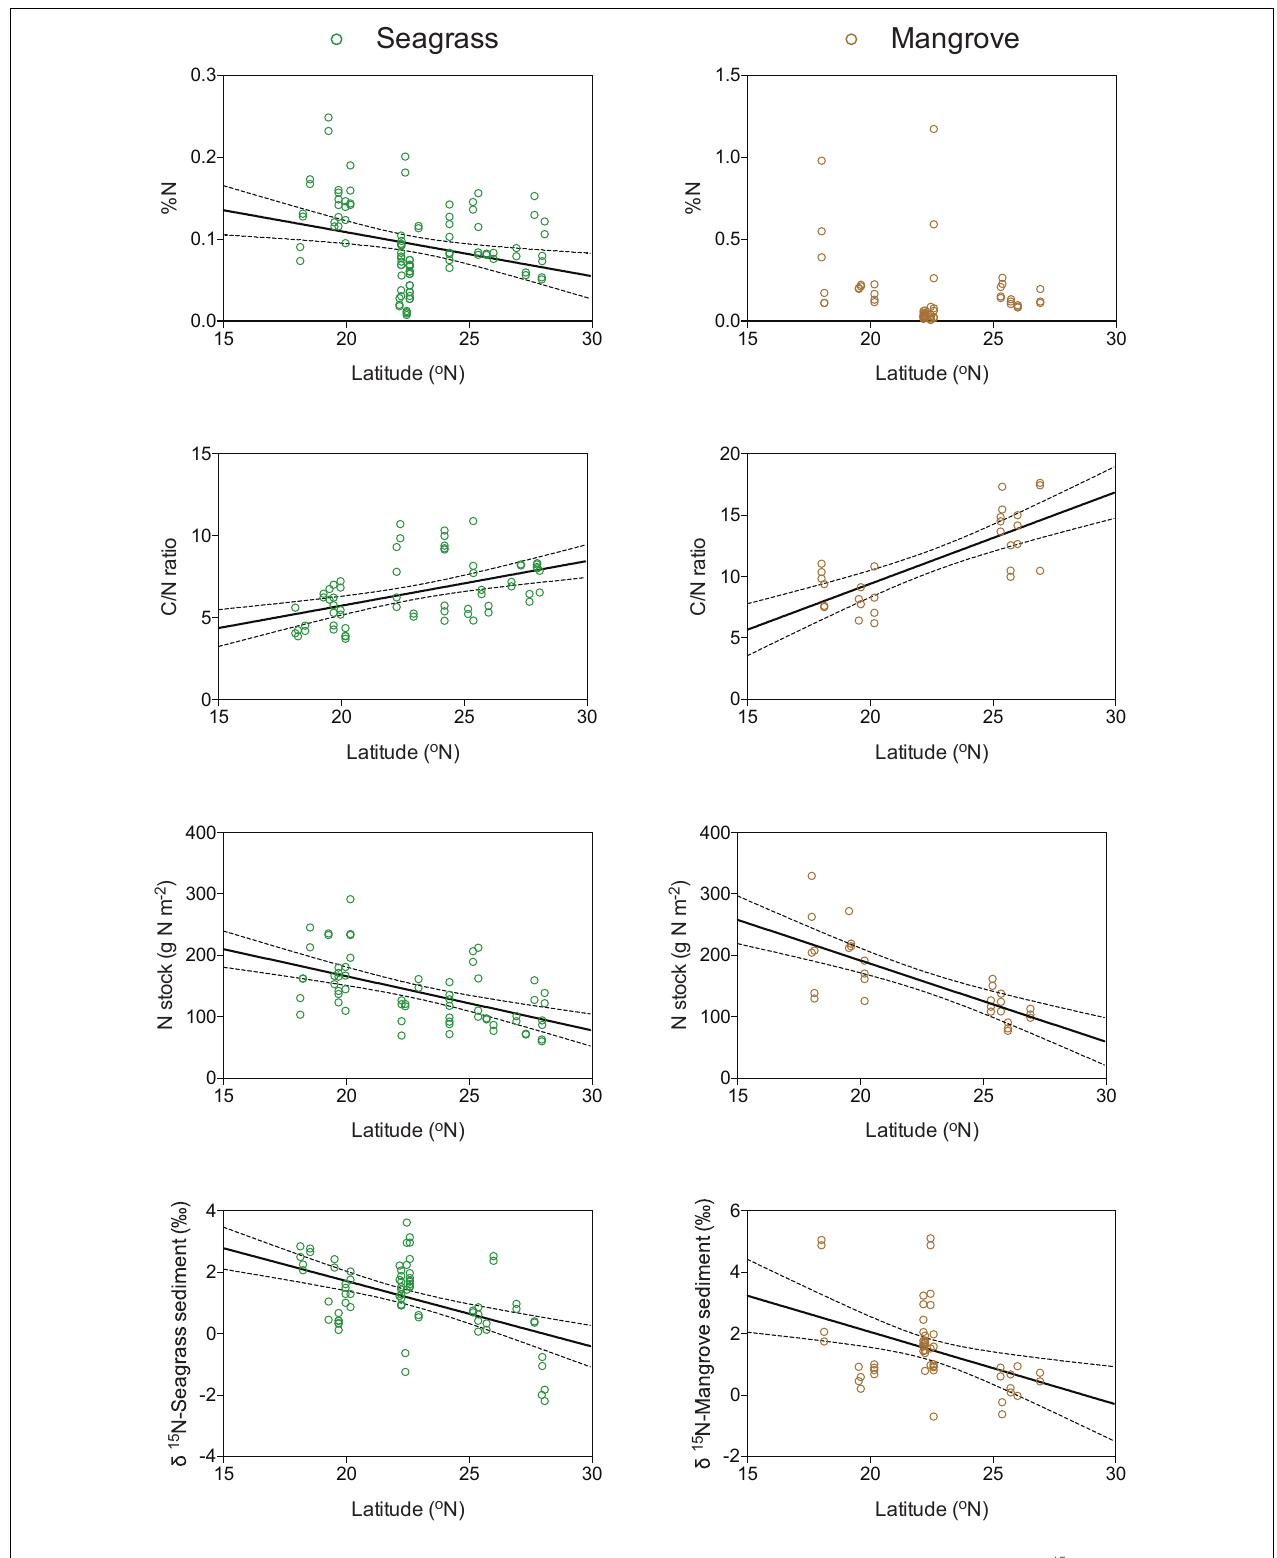
FIGURE 4 | Relationship between latitude and the N concentration, the C/N ratio, the N stock over the top 10 cm of sediment, and the δ 15 N composition of seagrass (green) and mangrove (brown) sediments. The solid lines represent the linear regression ± 95% c.i. (dashed lines).